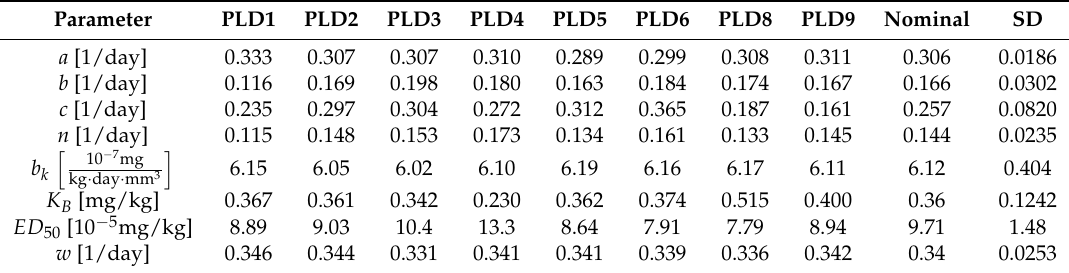
Table 1. The identified parameters of the mice from experiment specified in [14] using a mixed-effect model [7], along with the mean values and standart deiations for each